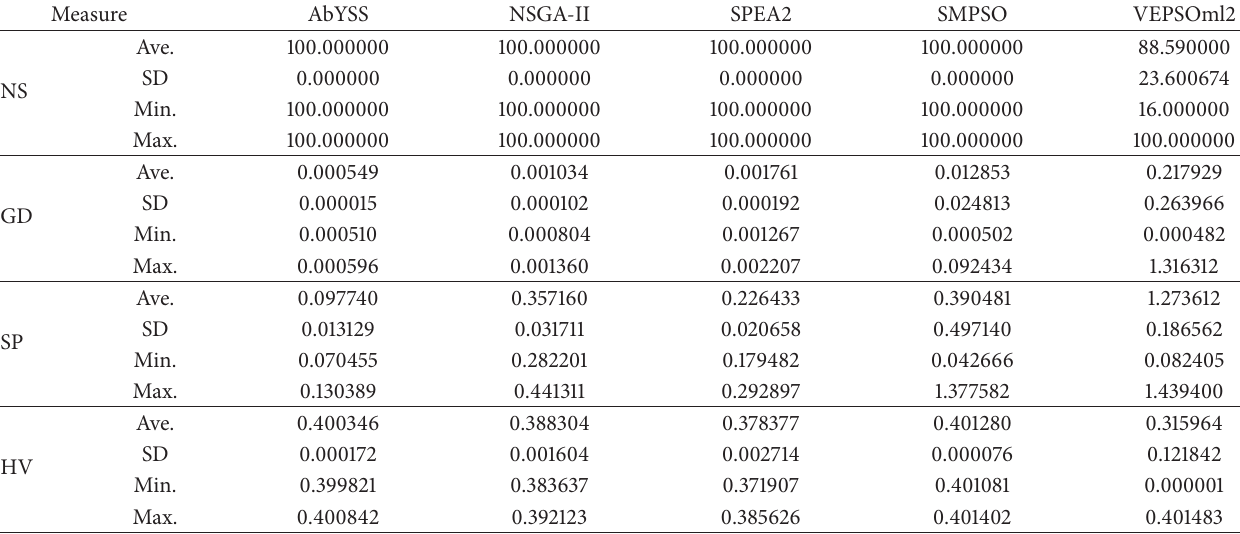
Table 11: Performance comparison based on ZDT6 test